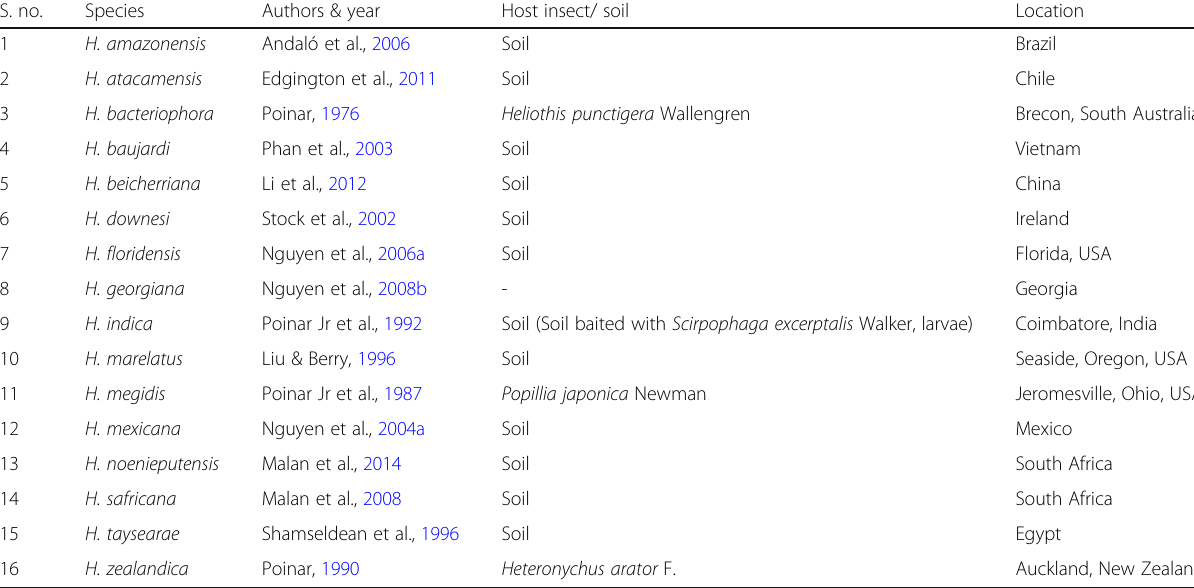
Table 2 List of Heterorhabditis species recorded from different countries of the world S.